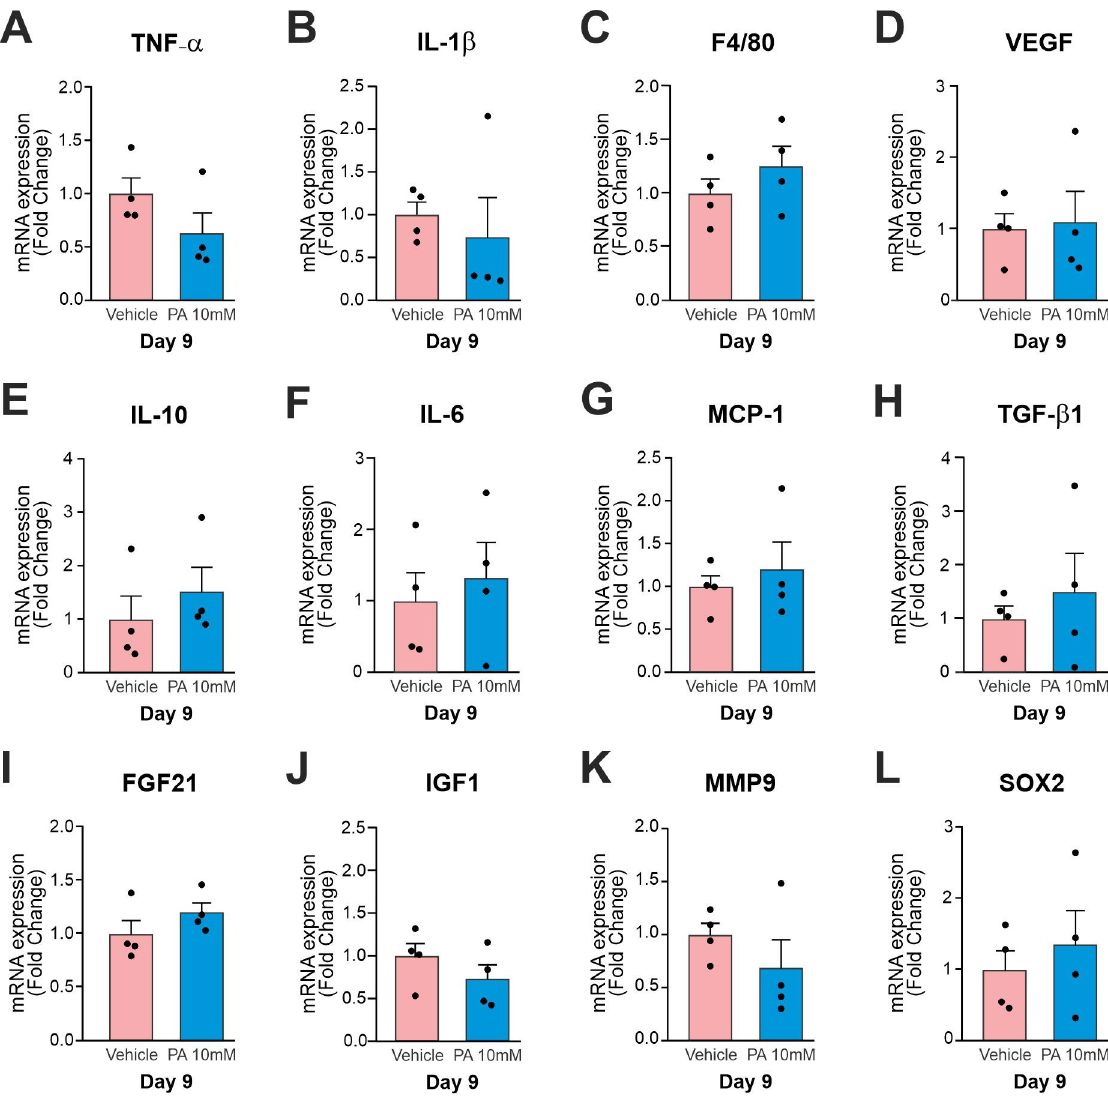
Fig 5. Expression of transcripts in the wounds on day 9 treated with 10 mM PA vs. vehicle. Real time PCR were employed to determine the expression of transcripts encoding for (A), Il-1 β (B), F4/80 (C), Vegf (D), Il-10 (E), Il-6 (F), Mcp-1 (G), Tgf- β 1 (H), Fgf21 (I), Igf-1 (J), Mmp-9 (K), and Sox2 (L). In all experiments n =